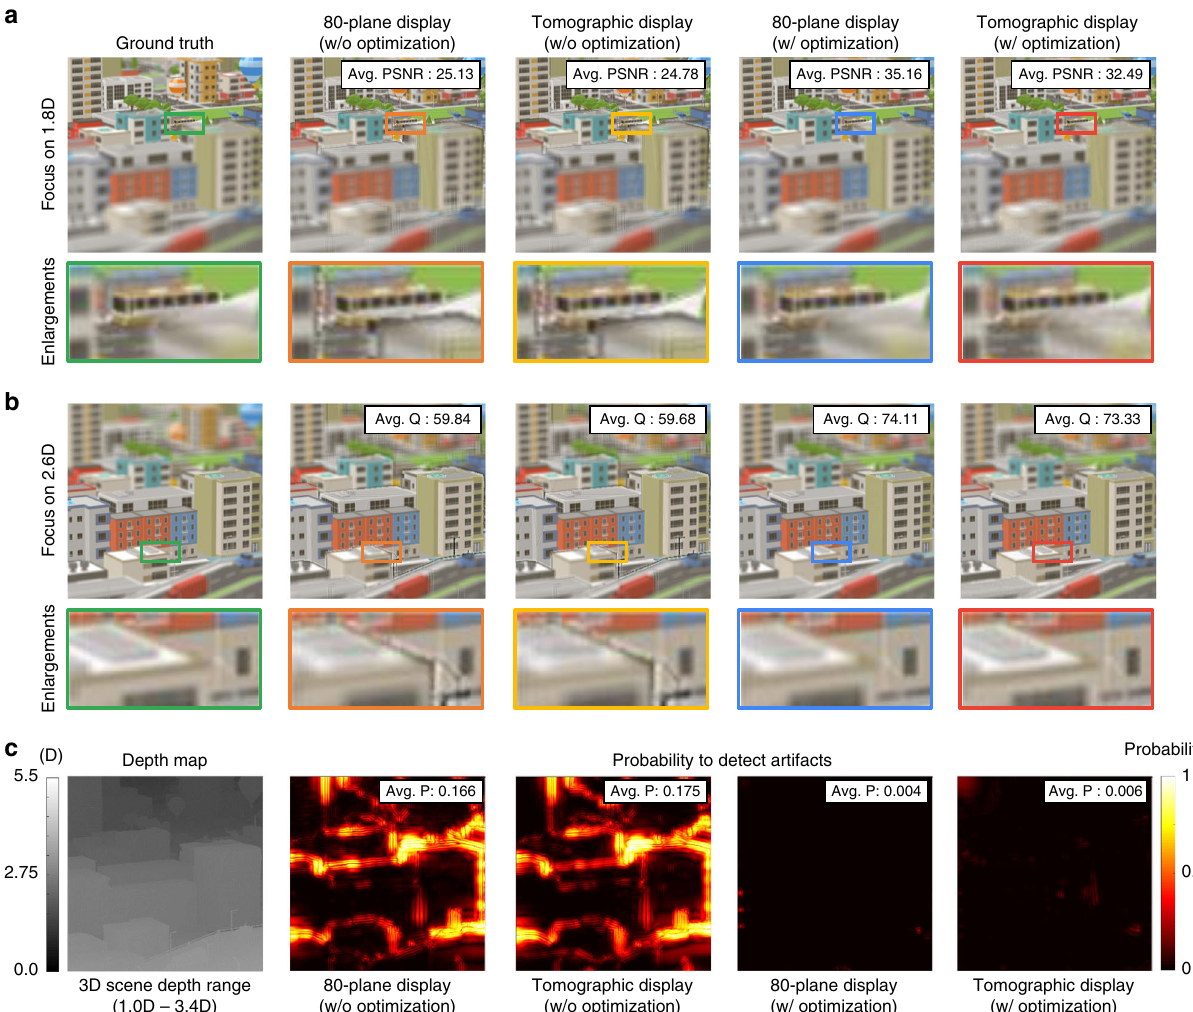
Fig. 5 Quantitative evaluation of tomographic displays. A volumetric scene (Source image courtesy: “ SimplePoly Urban ” , www.cgtrader.com) extends along the depth range between 1.0D and 3.4D. a , b Tomographic displays show the similar display performance with 80-plane displays in terms of average PSNR (Avg. PSNR) and average Q (Avg. Q). The Avg. PSNR is derived from the weighted sum of errors between the ground truth and synthesized retinal images. The weight is estimated by the reciprocal of the optical blur kernel size. The Avg. Q is the mean value of all focal stack images ’ Q values. c We demonstrate a probability map of detection for visual differences between the reconstructed scenes and the ground truth. Each pixel value indicates the weighted average probability over all the focal depths of observers. The average probability (Avg. P) is the mean value of all pixels. In Supplementary Note 4, we present focal plane images for each display system and additional comparison results from other related